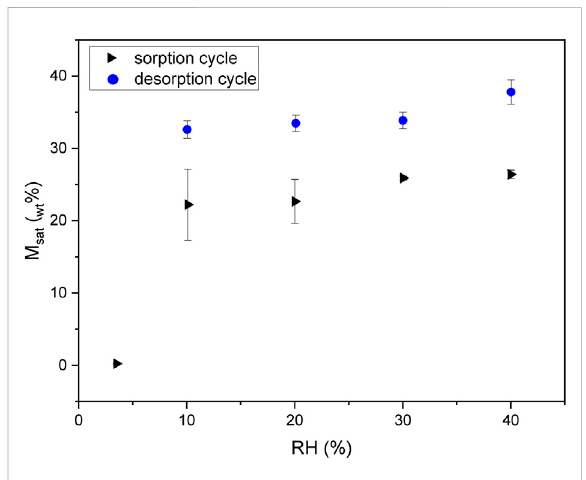
Moisture sorption and desorption isotherm of KOH crystals exposed to varying humidity.